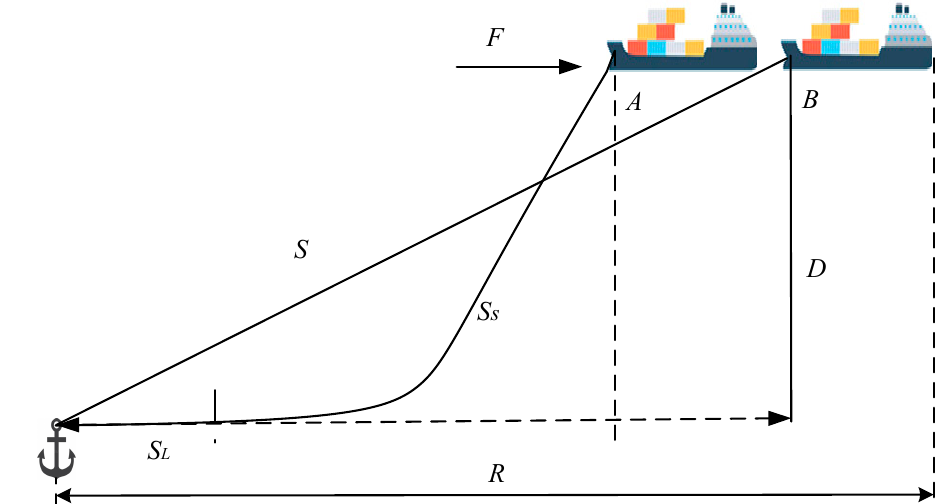
Figure 3. Diagram of vertical movement of anchoring ship.